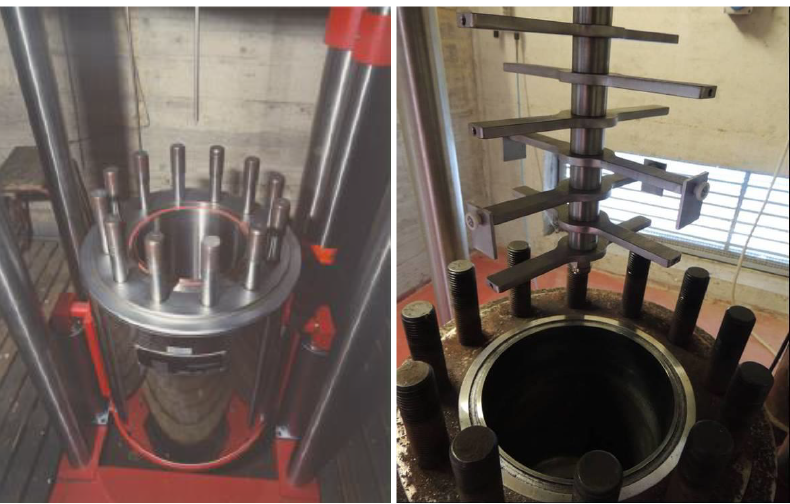
Figure 1. Autoclave (20 L) for corrosion testing with the water stirring apparatus.